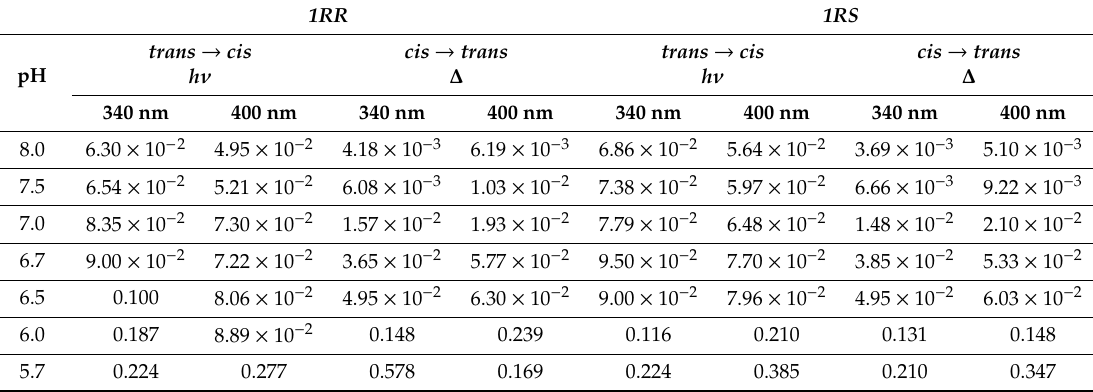
Figure 3. ( A – D ) d 1RR trans to cis conversion (pH = 8.0) under 5 mW laser irradiation at 435 nm. ( A ) Time-dependent absorption spectra of d 1RR . ( B ) 2D graphical representation of the changes of absorbance of d 1RR plotted as a function of time. ( C , D ) The changes of absorbance at specific wavelengths, 340 and 400 nm, together with their best fit (red solid lines). Reaction half-lives and apparent rate constants are deduced on these fittings. Table 1. Apparent rate constants calculated in s − 1 from kinetic data by means of fast UV spectroscopy. The reported values have about 10% uncertainty.